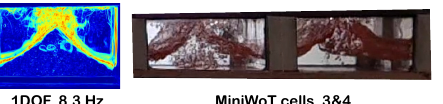
Figure 18. Average liquid surface location in 1DOF harmonic excitation tests [7] ( left ) and MiniWoT cells 3&4 sloshing pattern ( right